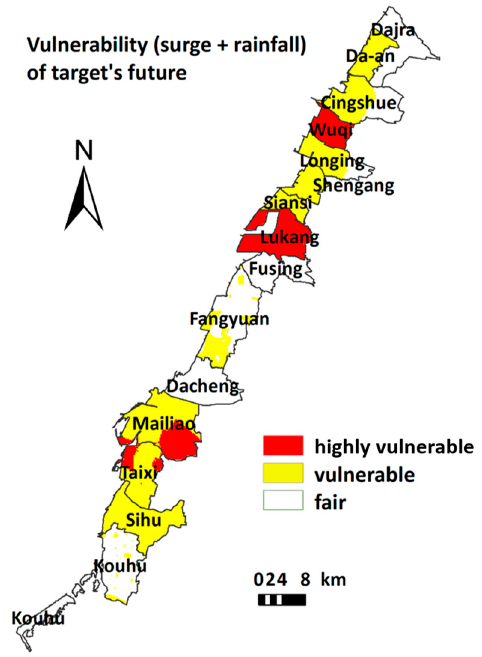
Figure 4. Vulnerability map of target’s future (2020–2039), considering surge tides and precipitations using AHP weights.